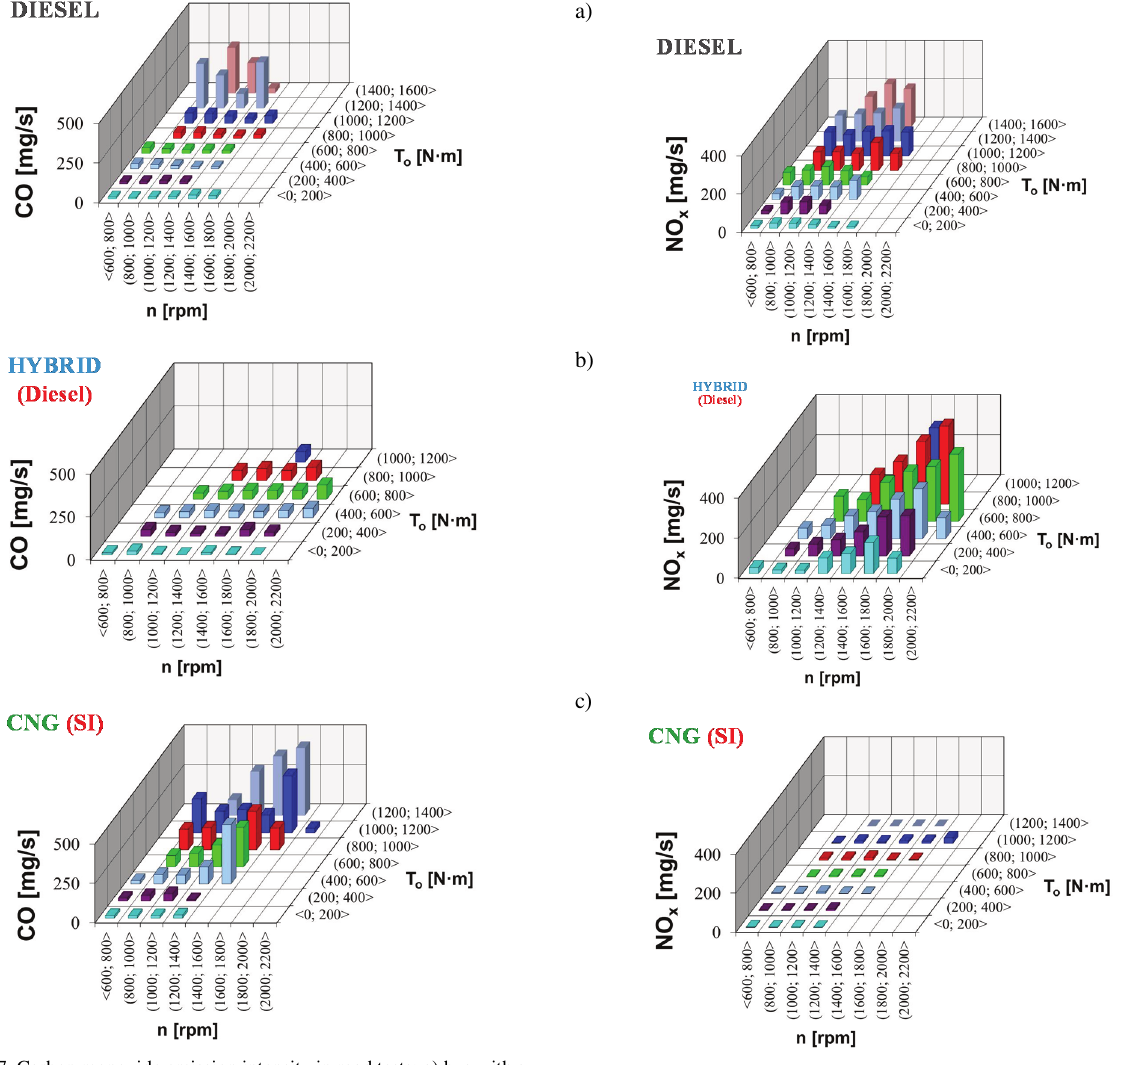
Fig. 28. Nitrogen oxides emission intensity in road tests: a) bus with a diesel engine, b) hybrid bus, c) bus powered by natural